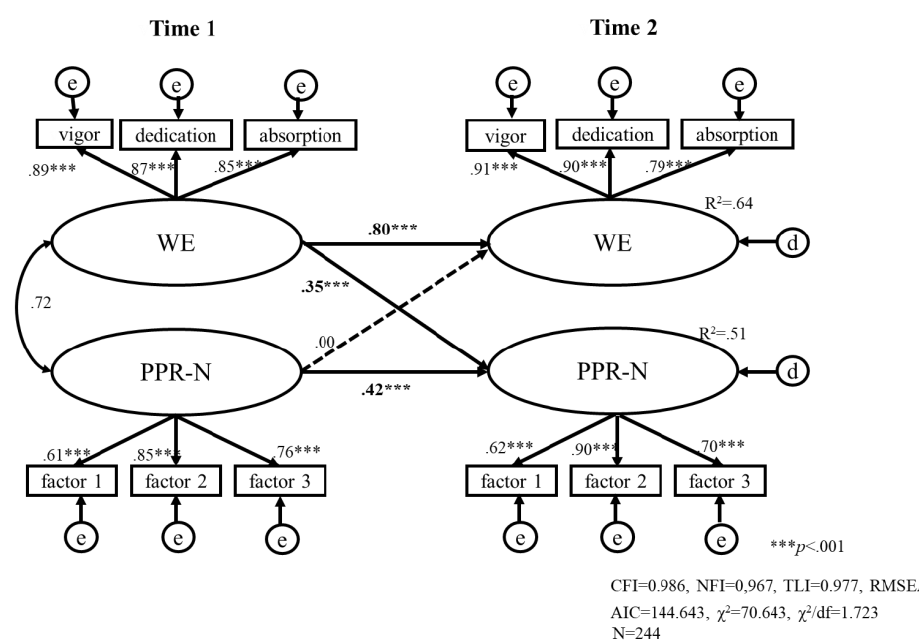
Figure 4. Model (b). The causal relationship between work engagement and personal and professional resources for nurses to work vigorously using a cross-lagged effects model in nurses with more than 10 years of work experience (mid- and later-career nurses).